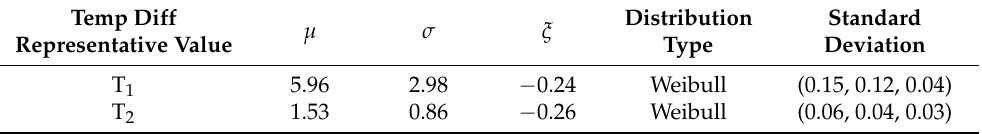
Table 2. Sample data parameter estimation and extreme distribution types of steel box girder. Temp Diff